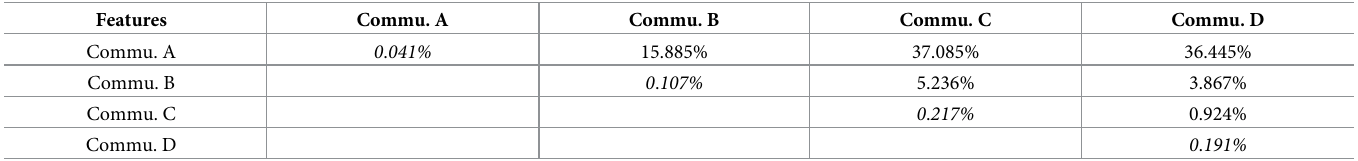
Table 2. Accumulated feature importance between each ML community